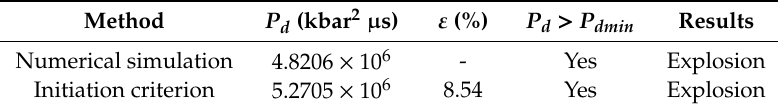
Table 8. Comparison of the simulation results and calculation